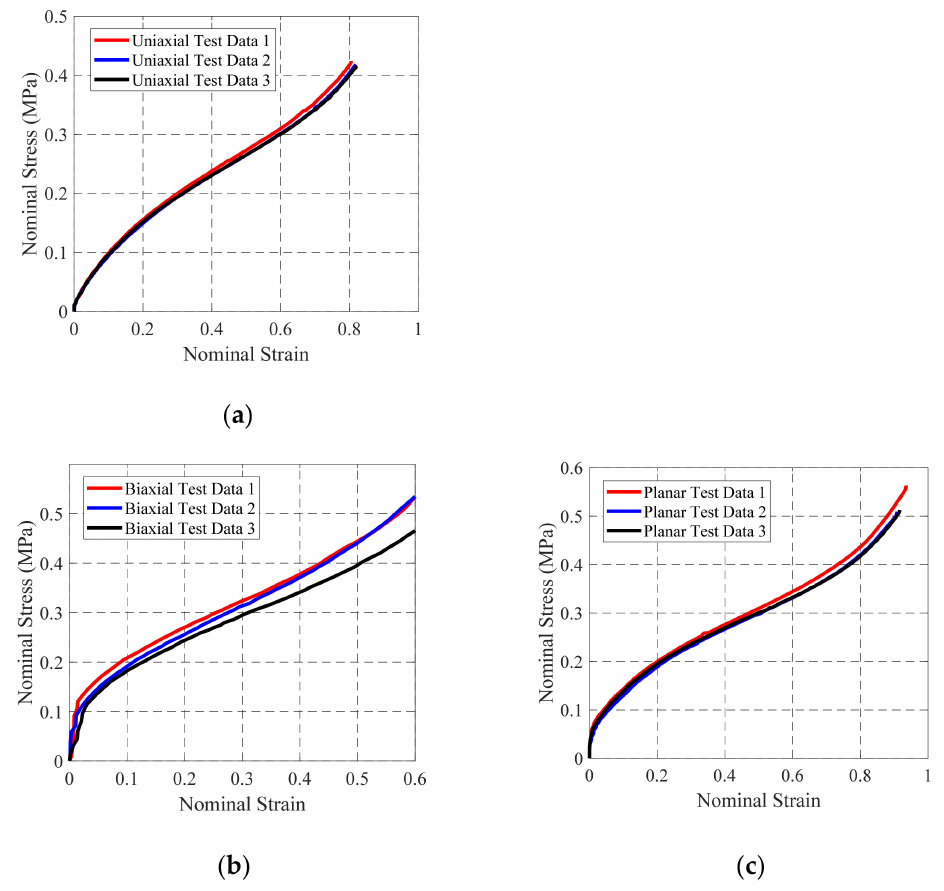
Figure 5. Rubber sample nominal stress-strain curves: ( a ) Uniaxial tensile test; ( b ) Equal biaxial tensile test; ( c ) Plane tensile test.